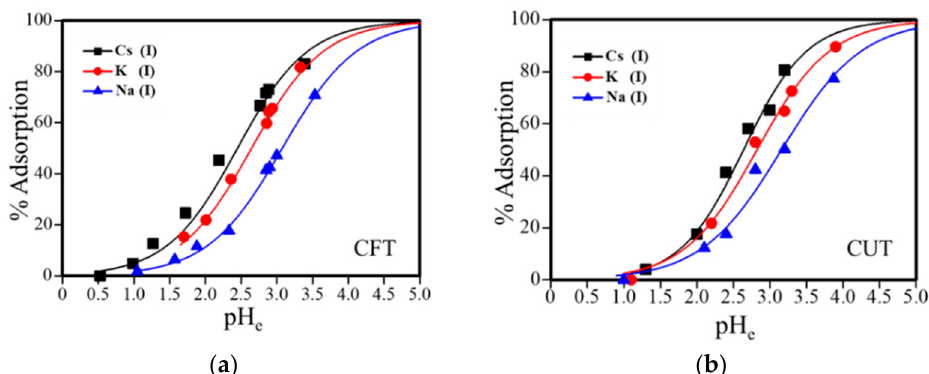
Figure 4. Effect of pH dependency on adsorption of alkali metal ions on ( a ) crosslinked fresh tea leaves